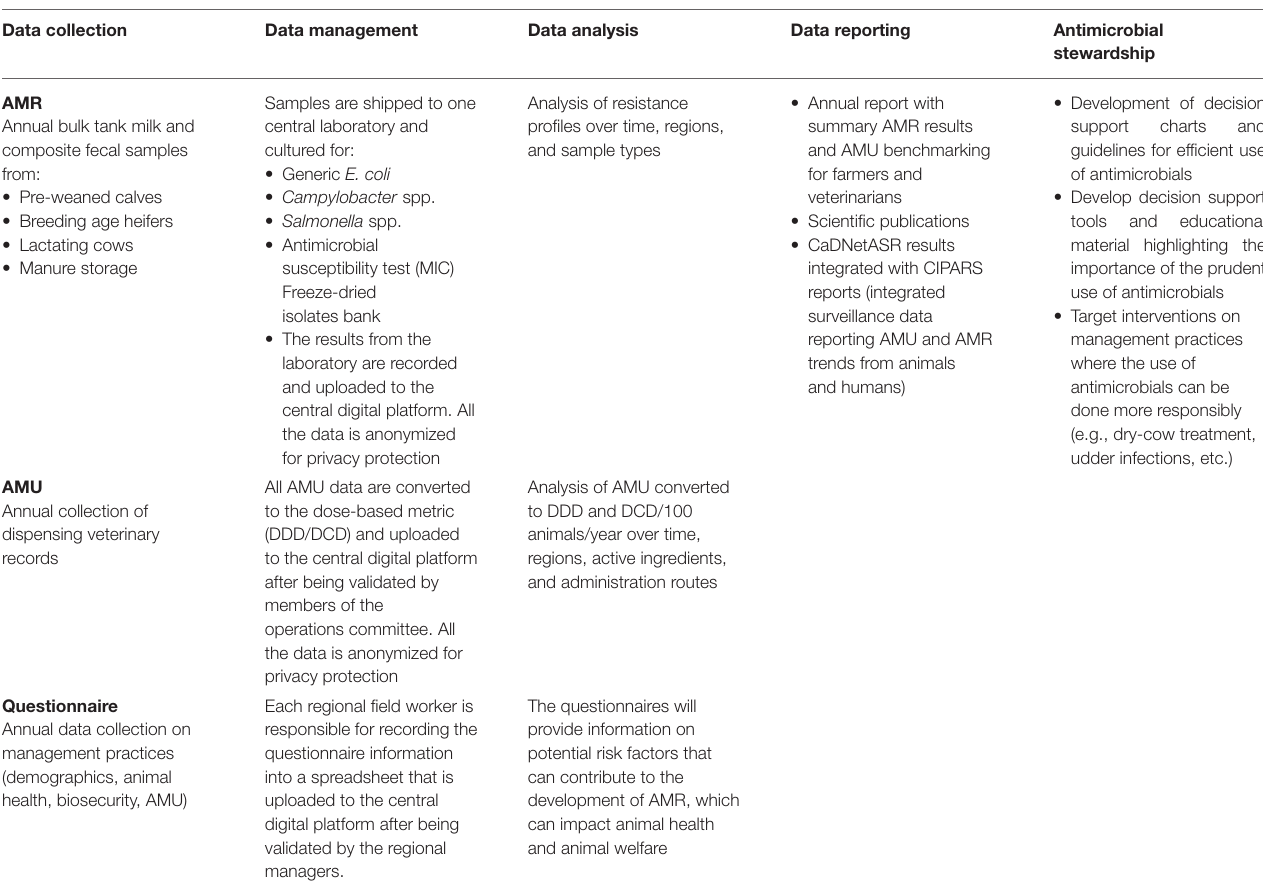
TABLE 3 | Summary of the key activities of the CaDNetASR on-farm surveillance system. Data